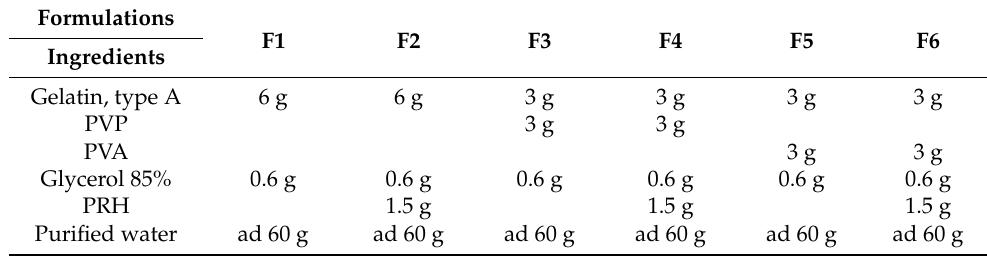
Table 1. Composition of paste formulation for mucoadhesive buccal films.